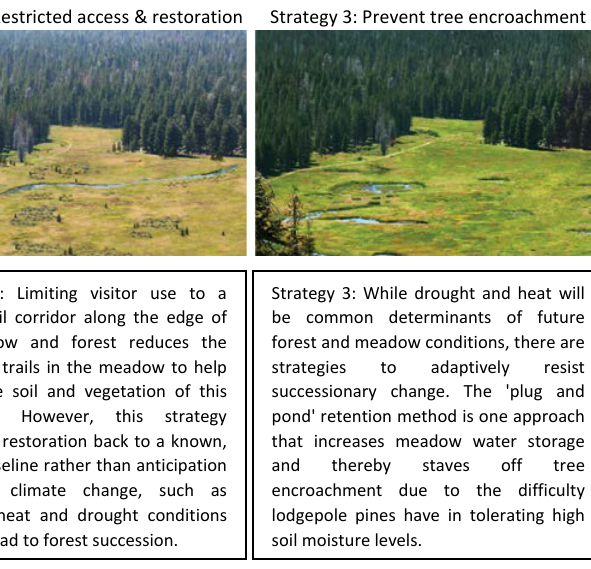
Strategy 1: Unrestricted social trails Strategy 2: Restricted access &